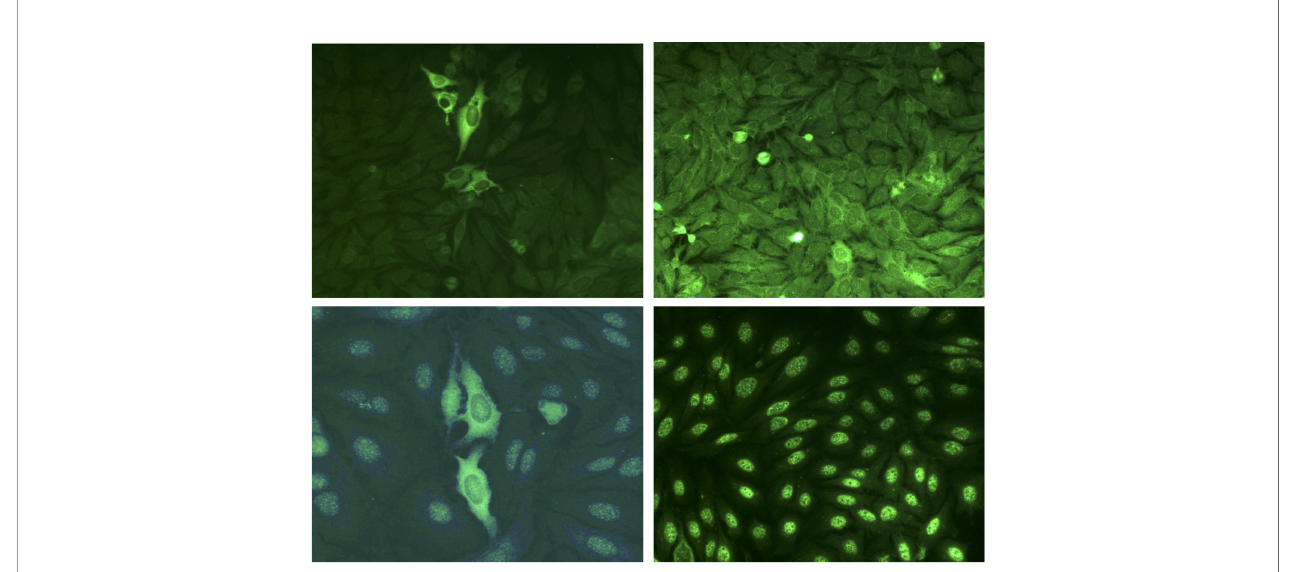
FIGURE 2 | Indirect immuno fl uorescence patterns of HEp-2 cells stained with anti – MDA5 positive sera. Stainings were performed on HEp-2 cells (Kallestad, Biorad) with sera from patients with anti-MDA5 Abs dermatomyositis. Top left: typical fi ne granular cytoplasmic staining in rare clustered cells. Top right: granular cytoplasmic pattern in all cells (which can mask the typical cytoplasmic pattern). Bottom left: nuclear speckled pattern, associated with the typical cytoplasmic pattern. Bottom right: isolated nuclear speckled pattern. Note that absence of fl uorescence can also be observed with some